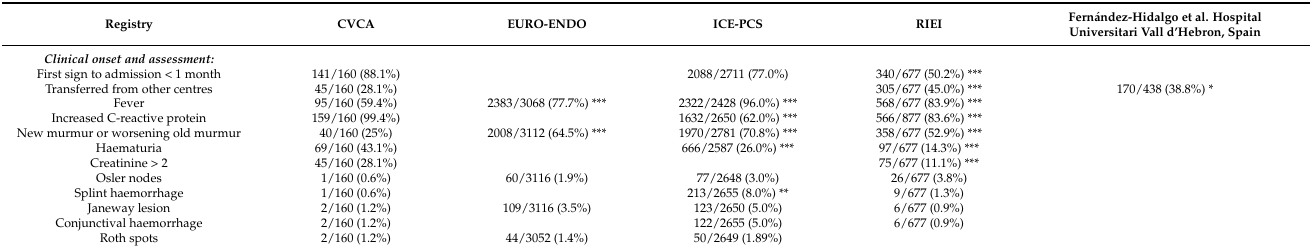
Summary of the clinical onset and assessments reported in the five studies. Cell markings with asterisks represent the statistical significance levels of the two-sample Pearson’s chi-squared tests for the observed proportions. Reported significance levels for pairwise comparison between OLV Hospital and each of the four other registries individually are the following: no asterisks marking given for p >= 0.05, * for p < 0.05, ** for p < 0.01 and *** for p <